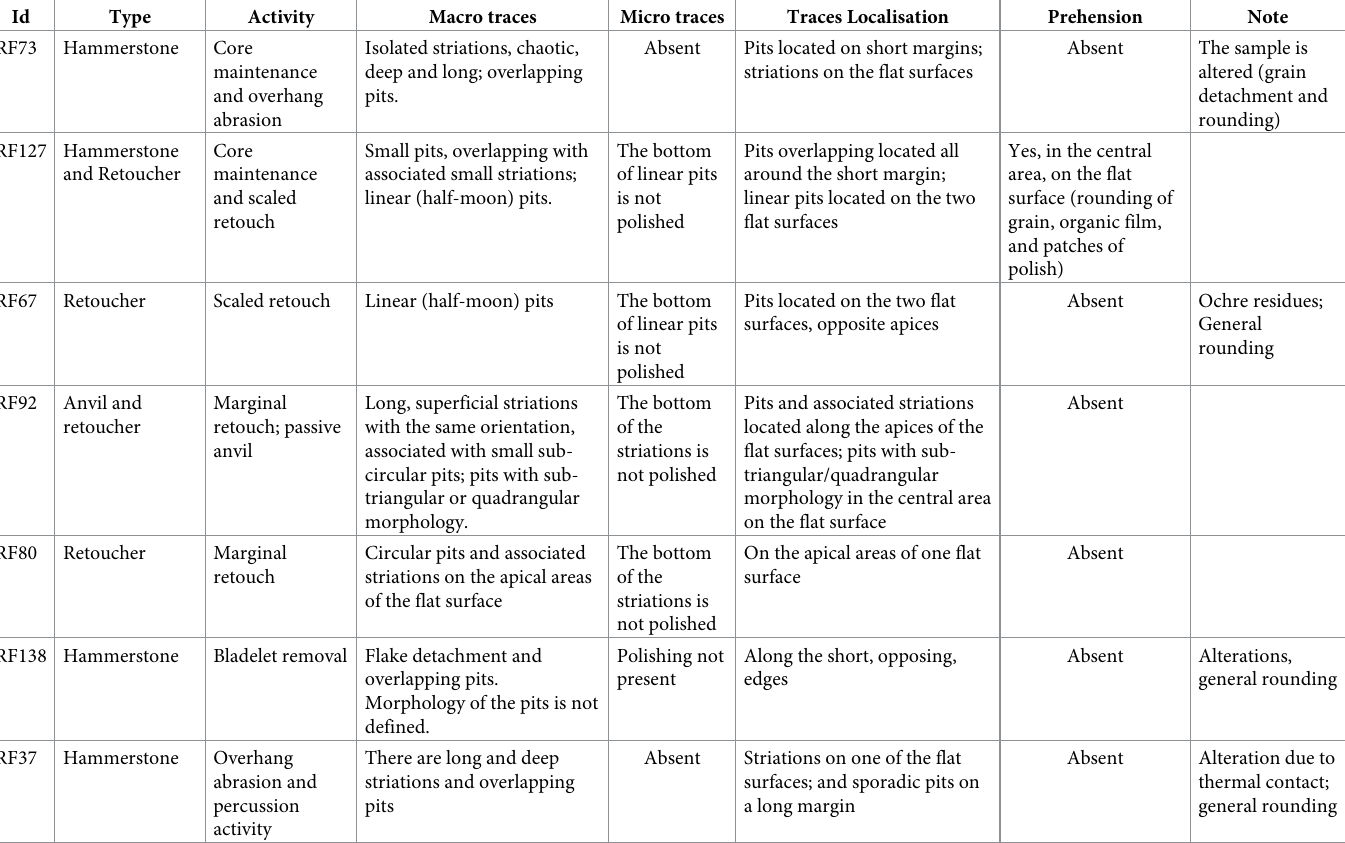
Table 4. Archaeological sample and use wear description and